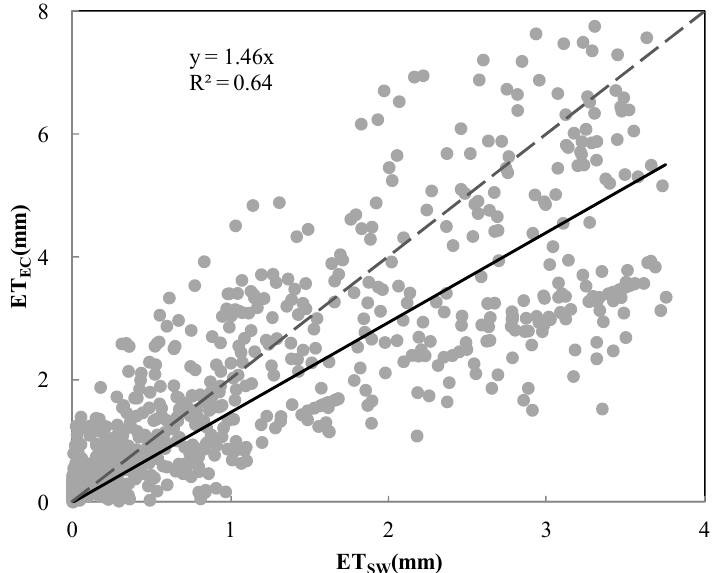
Figure 2. Comparison between SOILWAT2 based daily ET (ET SW ) versus eddy covariance-based values (ET EC ) for the period from May to September, 2016–2018. The dashed lines represent the 1:1 relation.